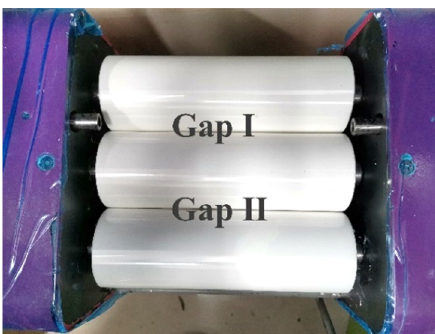
Figure 1. The three rollers and two gaps of a three-roll milling machine. During dispersion, the epoxy resin and CNM mixture was squeezed through the small gaps between the three rollers via rotary extrusion. The CNM–epoxy mixture was first passed through a gap I (Figure 1), then passed again through gap II (Figure 1). The mixtures were milled and dispersed twice during a single milling process to complete one cycle. The gap distance between the rollers was controlled, with a specific range of 1–150 microns. Twelve repetitive cycles were conducted during the dispersion process (Figure 2a), and the gap distance was gradually reduced with each cycle. Table 2, from the research of Wang et al. in 2020 [22], shows the decrease in gap distance of gaps I and II as the number of milling cycles increased. After a total of twelve milling cycles, a good dispersion of the